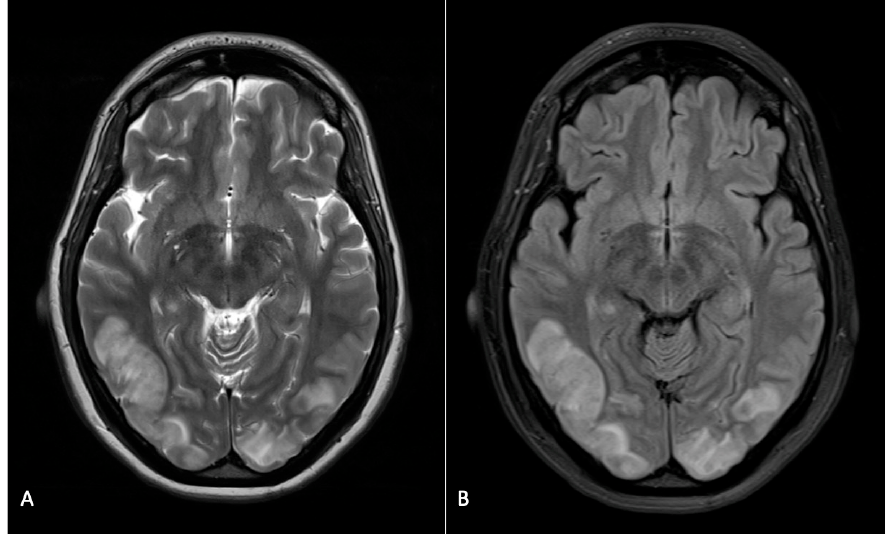
Figure 3. Representative MR images for PRES. Pregnant woman with posterior progressive headache due to PRES. MRI reveals bilateral occipital hypertensities of the brain parenchyma and cortex on T2 ( A ) and FLAIR ( B ) images.